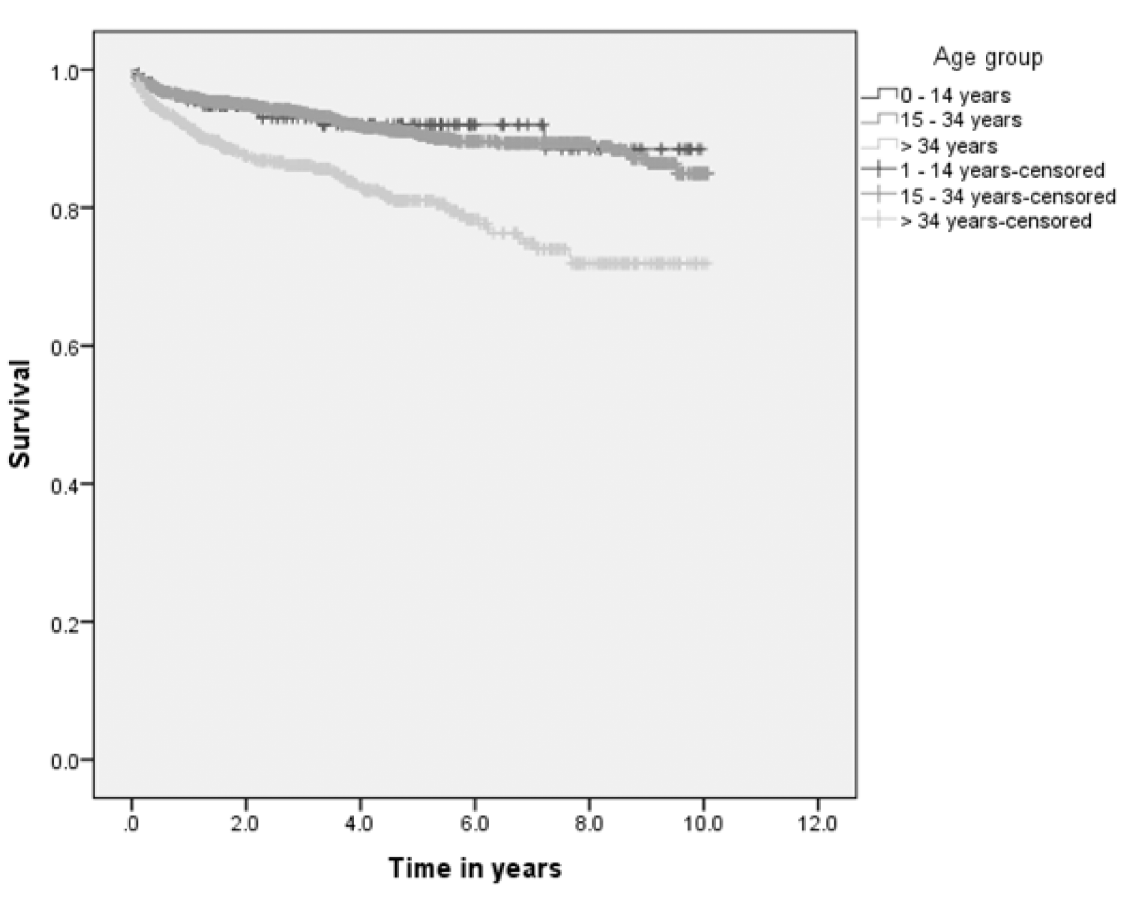
Fig 2. Survival probability of TB patients by age group in Dale district, South Ethiopia.